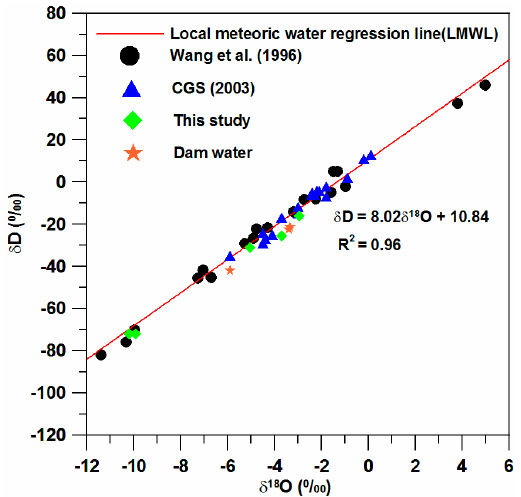
Figure 3. Plot of δ D vs. δ 18O for precipitation samples. LMWL represents local meteoric water line for Penghu Islands.